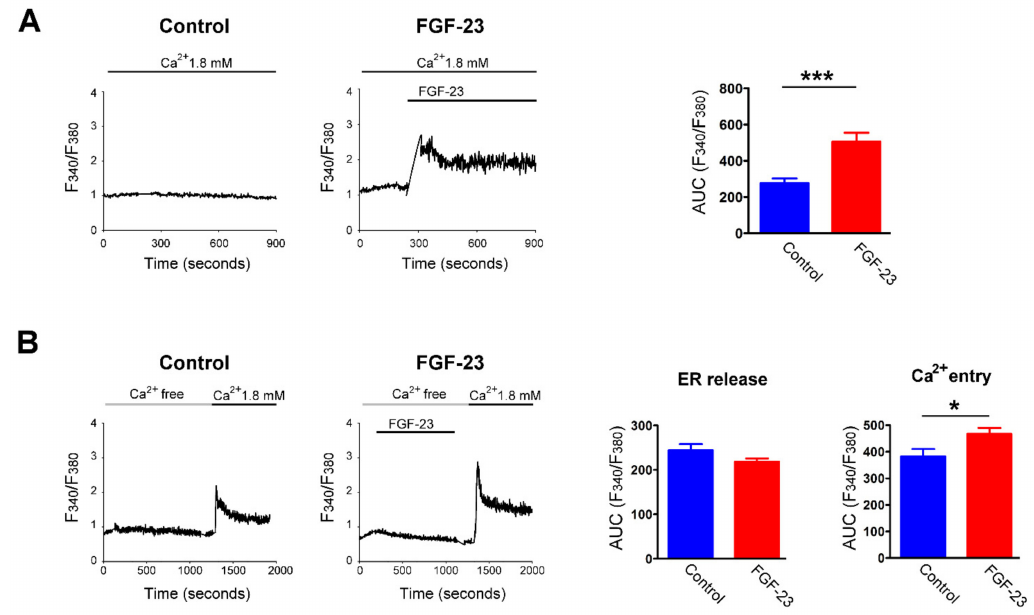
Figure 4. Fibroblast growth factor (FGF)-23 induces a rapid increase in intracellular calcium (Ca 2+ ) concentration through enhancing Ca 2+ entry. ( A ) Representative fura-2 fluorescence tracings (left